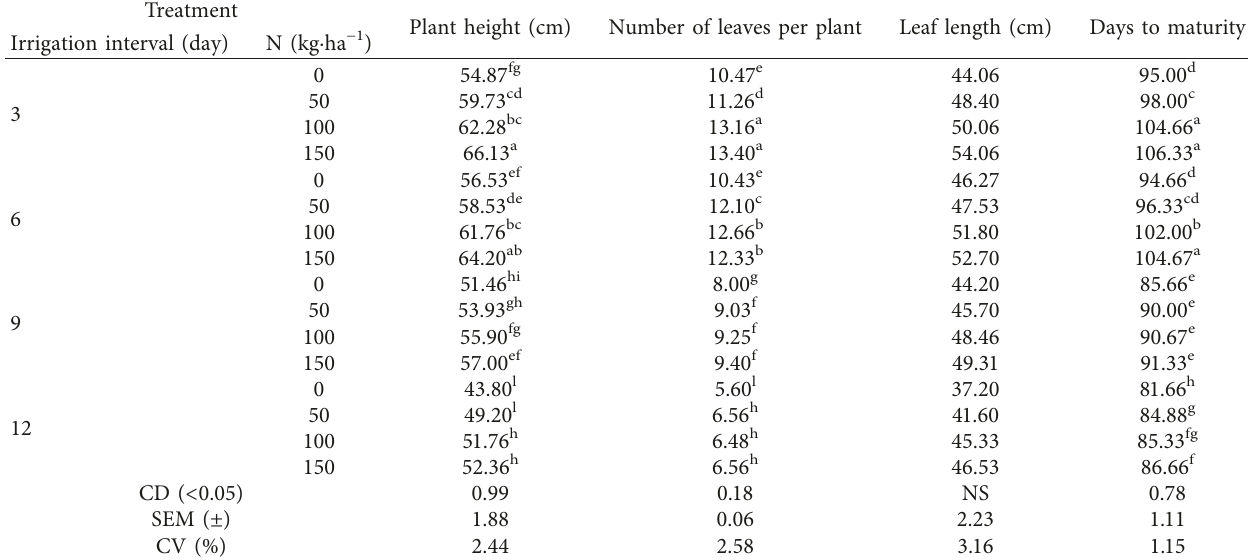
Table 4: Interaction effect of the irrigation interval and N rate on growth parameters of